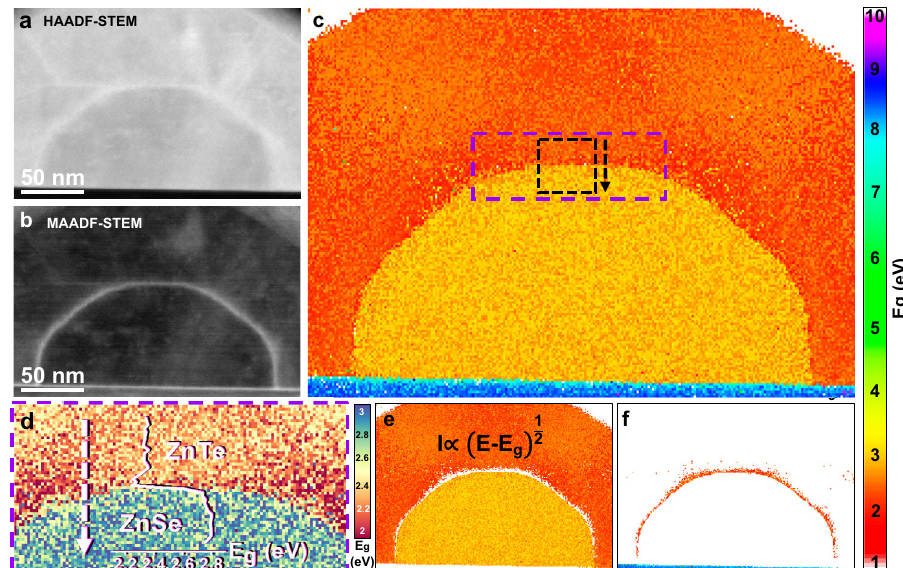
Fig. 5 Measured band-gap maps. a HAADF-STEM and b MAADF-STEM micrographs of a ZnSe-ZnTe core-shell nanowire grown on C-plane sapphire to which the band-gap mapping methodology has been applied. c VEELS-band-gap map of the system. The dotted purple square indicates the zoomed-in area displayed in ( d ), in which the 2 – 3 eV scale allows for a better qualitative representation of the theoretically predicted decrease in the band-gap at the strained ZnSe-ZnTe interface. This tendency is quantitatively observed in the black curve superimposed in ( d ), which has been horizontally averaged over the pixels included in the black dotted box and along the black arrow direction in ( c ). VEELS-band-gap map decomposition into the regions in which we observe either ( e ) a direct band structure (all ZnSe pixels and ZnTe “ bulk ” pixels), or ( f ) an indirect band-gap (ZnTe shell pixels at the core interface, and sapphire pixels). The pixels corresponding to the metallic polycrystalline Pt protective layer have been manually set to 0 eV (metallic behavior). Notice that the color bar represents the band-gap energy in